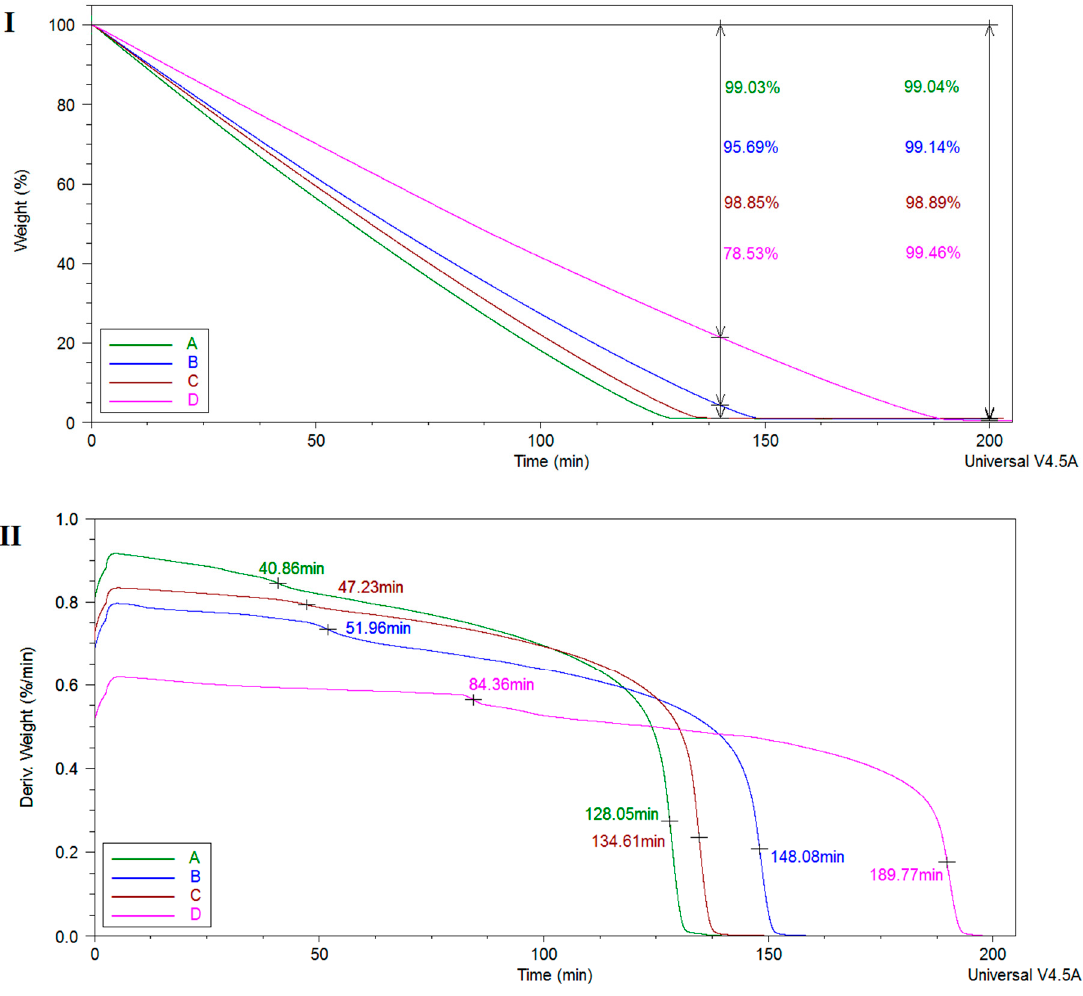
Figure 2. ( I ) Weight loss as function of time measured at constant temperature (37 °C) of the equilibrium swollen hydrogel samples; ( II ) Weight derivative as function of time for the equilibrium swollen hydrogel samples; A-PMAA; B-PMAA-Cl 93A; C-PMAA-Cl 93A-C8; D-PMAA-Cl